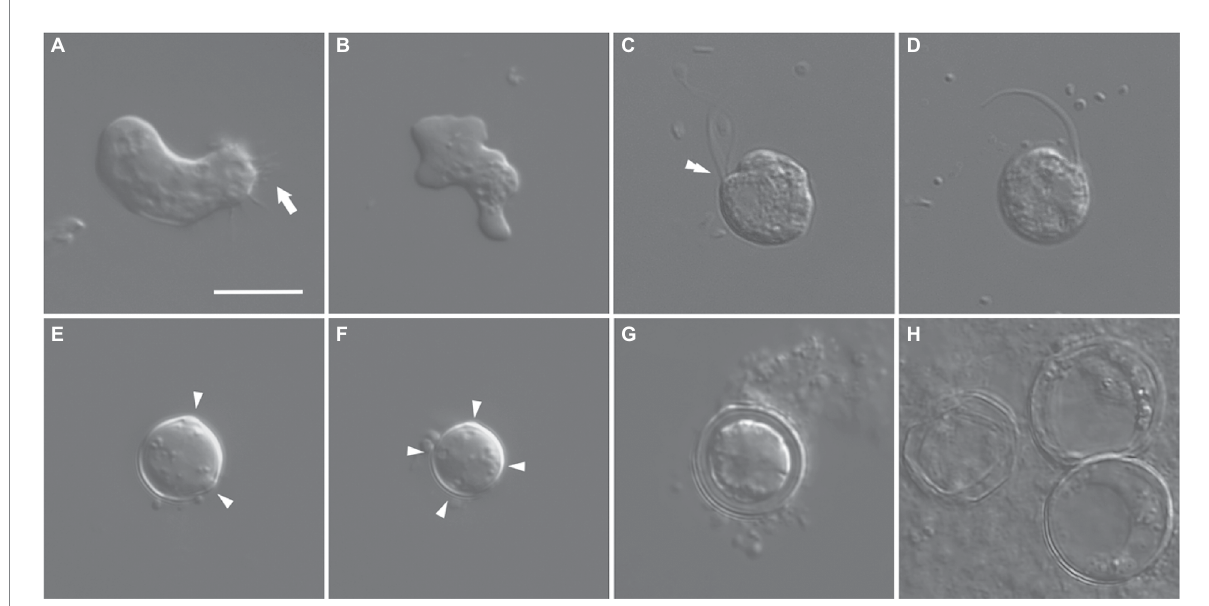
FIGURE 1 Differential interference contrast micrographs of Euplaesiobystra salpumilio sp. nov. (A,B) Amoebae (trophozoites), showing size and shape (monopodial or polypodial), and pseudopod formation. Arrow in (A) denotes uroidal filaments. (C,D) Flagellate phase, with double-arrowhead denoting rostrum. (E–H) Cysts with a round shaped, four cyst pores, and double wall. (G) Empty cyst (H) . Arrowheads in (E,F) denote cyst pores. Scale bar: 10 μ m for all figures.